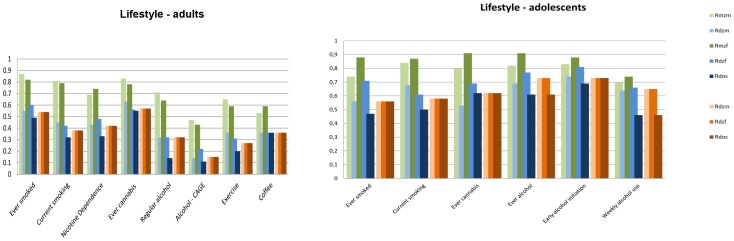
Twin correlations for Lifestyle variables.1A: adult twins and 1B: adolescent twins. The green bars represent correlations in Monozygotic Male (MZM) twin pairs (light green) and Monozygotic Female (MZF) twin pairs. The blue bars represent correlations in Dizygotic Male (DZM) twin pairs, Dizygotic Female (DZF) twin pairs and Dizygotic Opposite Sex (DOS) twin pairs. The green and blue bars reflect the correlations in a full model, while the orange bars reflect twin correlations for Dizygotic (DZ) twin pairs in the most parsimonious model, with: DZM (light orange), MZF (normal orange), DOS (dark orange).